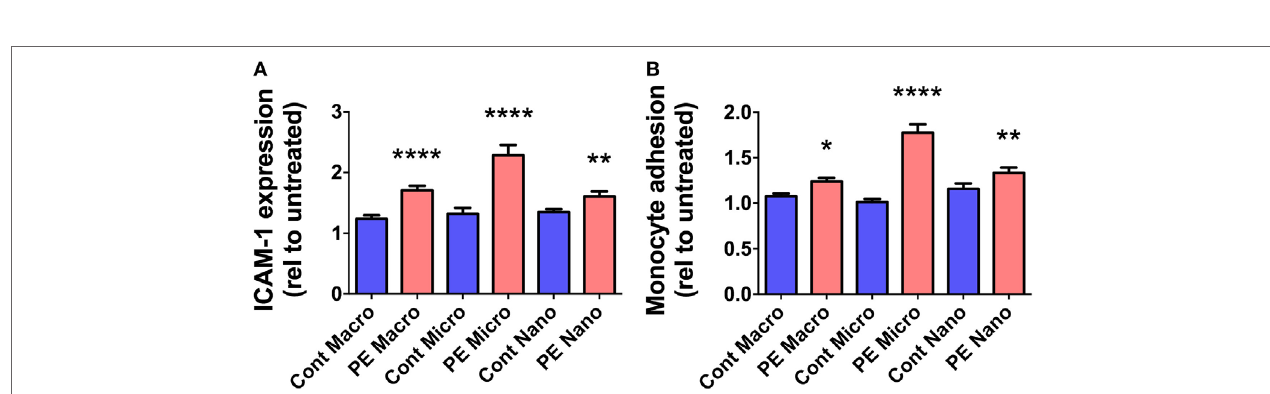
FigUre 2 | Levels of surface intercellular adhesion molecule 1 (ICAM-1) expression and monocyte adhesion by human microvascular endothelial cell line (HMEC-1) cells after co-culture with preeclamptic (PE) EVs. Human microvascular endothelial cells were co-cultured with macro-, micro-, and nano-vesicles from normotensive (cont, n = 6) and PE ( n = 6) placentae for 24 h. Endothelial cell activation was quantified by measuring surface ICAM-1 expression (a) and monocyte adhesion (B) . Values were normalized to that of untreated HMEC-1 cells, and data are shown as mean ± SEM (* p < 0.05, ** p < 0.01, ***** p < 0.0001, unpaired t -test).